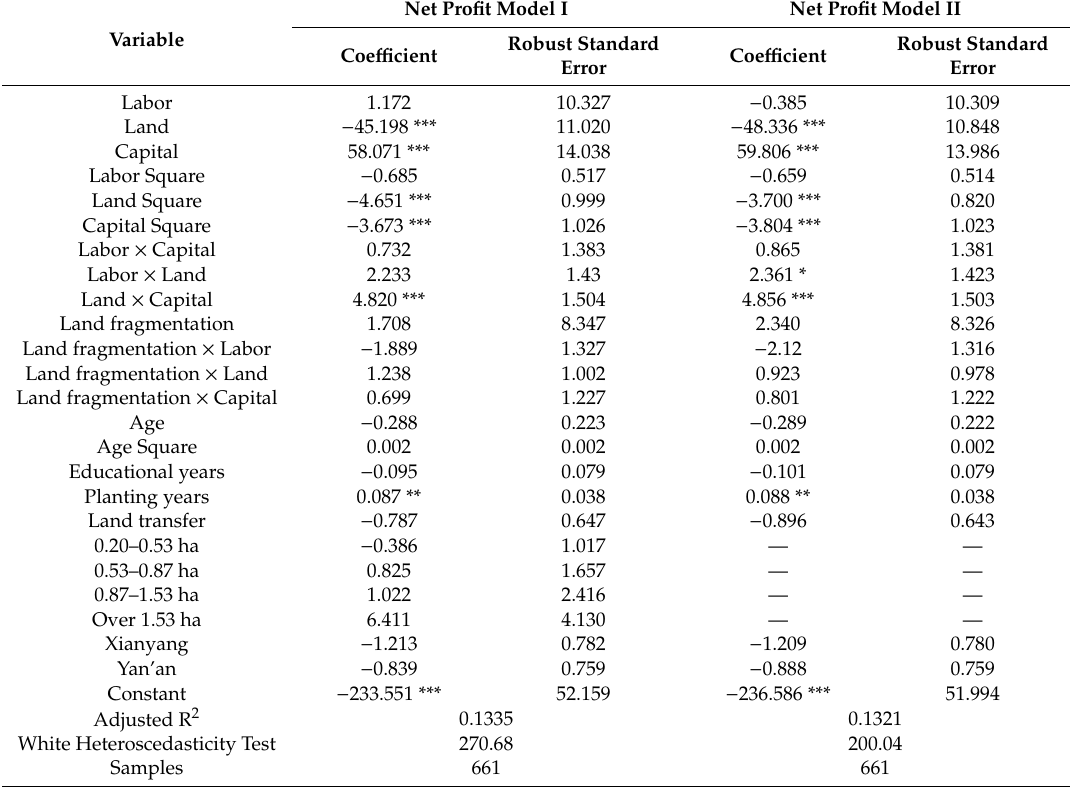
Table 5. Results of net profit